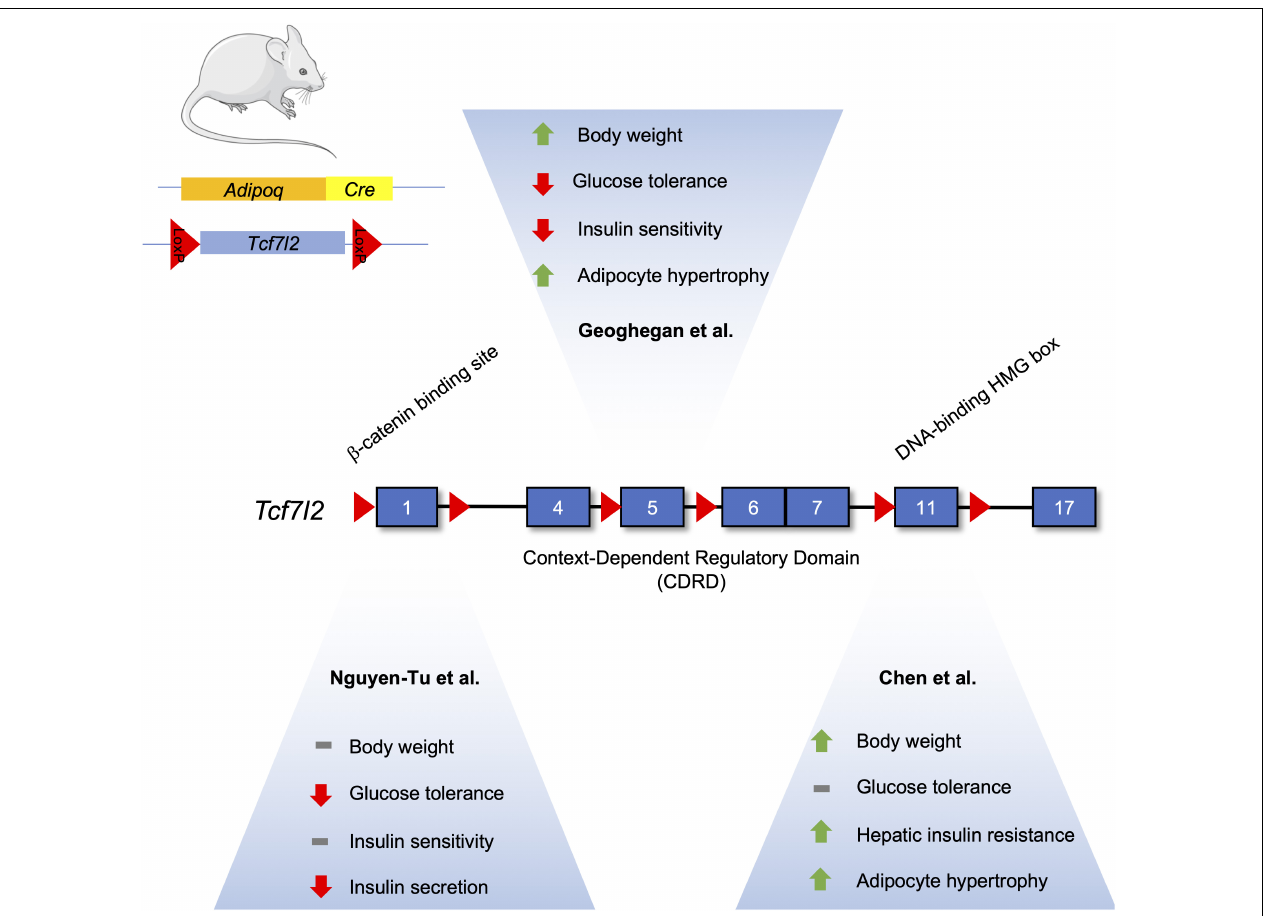
FIGURE 3 | Differences in the metabolic phenotype of adipocyte-specific TCF7L2 knockout mouse models. The Tcf7l2 gene contains 17 exons, as denoted by numerated blue rectangles. Recombination of floxed alleles for Exon 1 (Nguyen-Tu et al., 2021), Exon 5 (Geoghegan et al., 2019), and Exon 11 (Chen et al) by Cre recombinase under the control of the Adipoq promoter results in different metabolic phenotypes. This figure was made with modified images from Servier Medical Art (Creative Commons Attribution 3.0 Unported License).